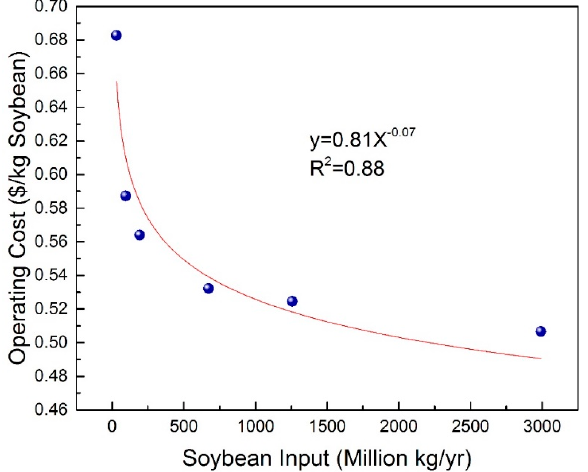
Figure 6. Non-linear relationship between net unit production cost and various scales of soybean oil production (outputs).